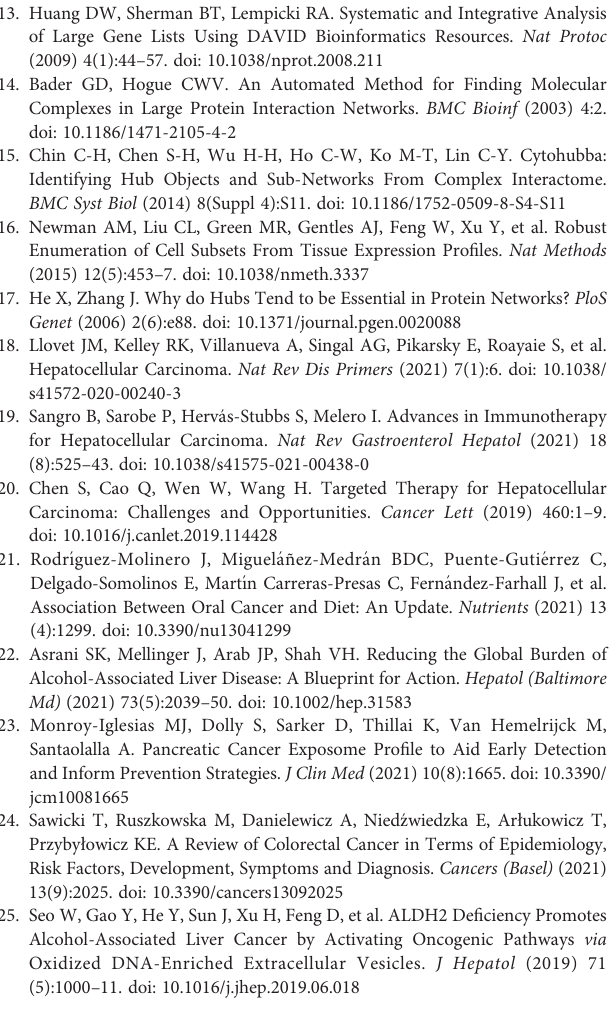
Supplementary Figure S1 | Tumor microenvironment analysis in high and low risk groups in different subgroups. (A) Differences in 22 immune cells between the high and low groups in alcohol-related HCC. (B) Differences in 22 immune cells between the high and low groups in age <60 subgroups. (C) Differences in 22 immune cells between the high and low groups in staging I/II subgroups. Supplementary Figure S2 | Comparison of tumor purity between high and low risk groups and correlation analysis between two genes and 22 immune cells. (A) Comparison of stromal score between high and low risk groups. (B) Comparison of immunescorebetween highandlowriskgroups. (C) Spearman correlation analysis between two genes and 22 immune cells. *P < 0.05, **P <